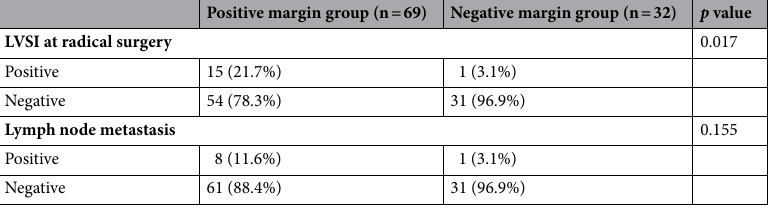
Table 2. The association between a positive margin at conization and metastatic potential in all patients. LVSI lymphovascular space invasion. p value of < 0.05 was considered statistically